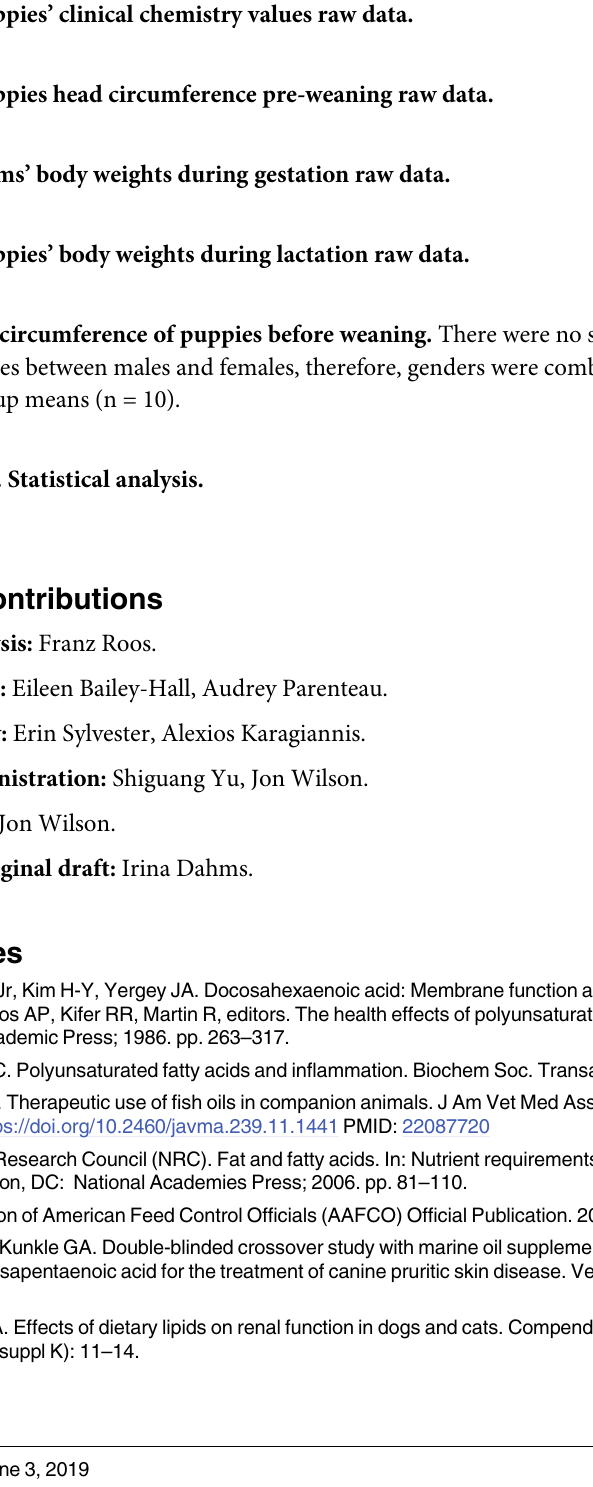
S3 Table. Dams’ clinical chemistry values following AOCED exposure starting at mating until the end of lactation. Values are given as mean ± SD (n = 5 in control; n = 4 in AOCED groups). S4 Table. Dams’ clinical chemistry values raw data. S5 Table. Puppies’ clinical chemistry values raw data. S6 Table. Puppies head circumference pre-weaning raw data. S7 Table. Dams’ body weights during gestation raw data. S8 Table. Puppies’ body weights during lactation raw data. S1 Fig. Head circumference of puppies before weaning. There were no statistically signifi- cant differences between males and females, therefore, genders were combined. Values are shown as group means (n =